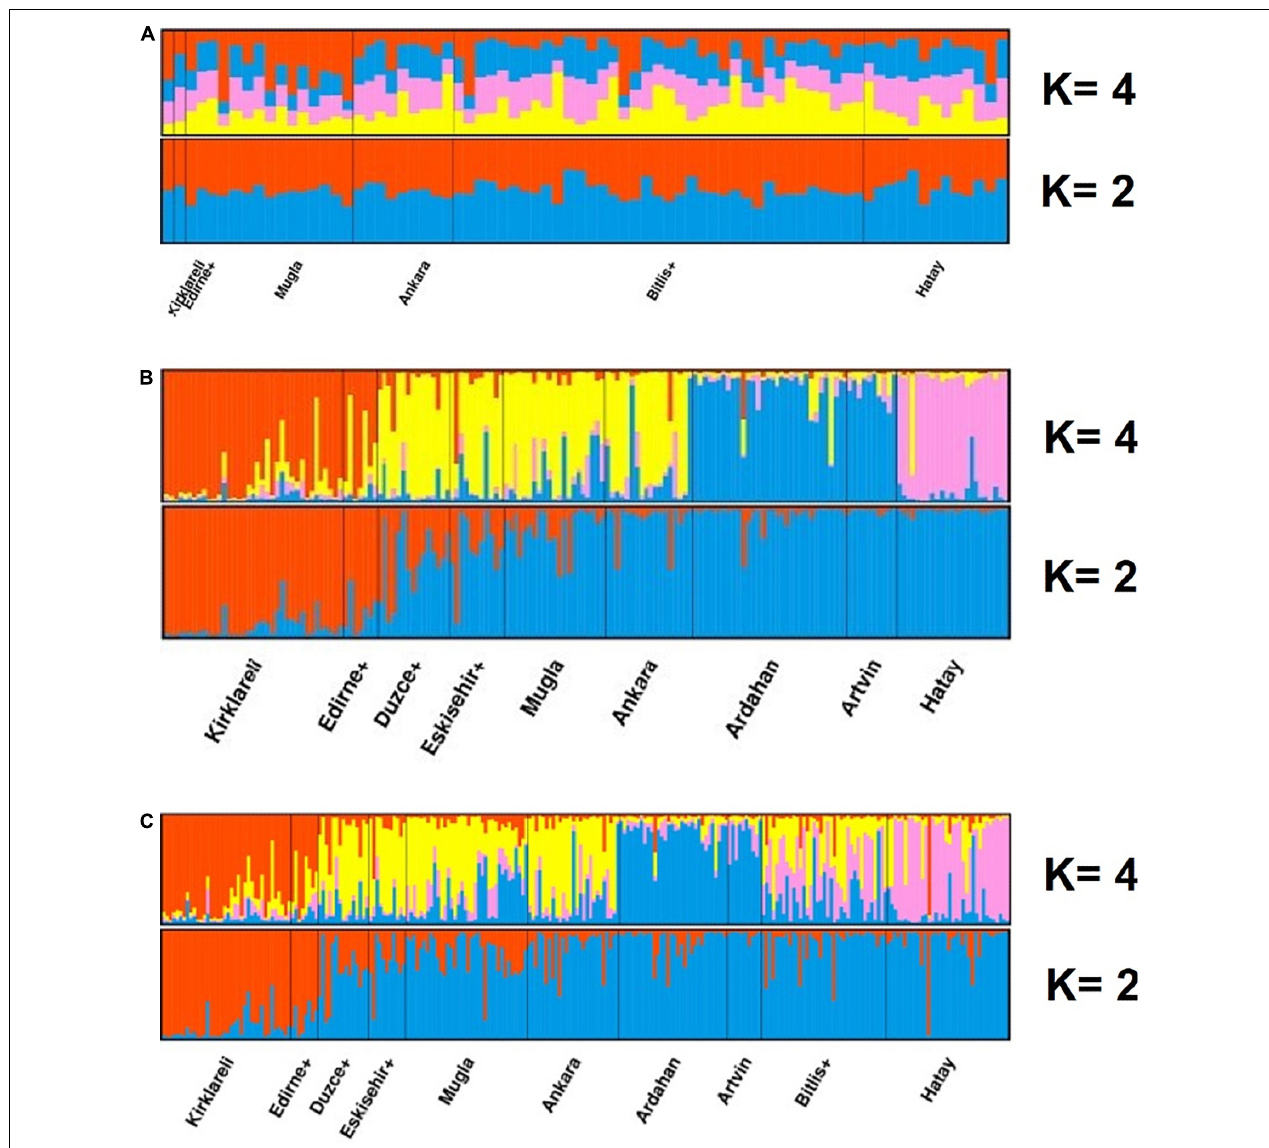
FIGURE 3 | Estimated population structure and clustering of honeybees in Anatolia and Thrace for (A) migratory colonies, (B) stationary colonies, and (C) the whole sample. Structure analysis is based on microsatellite data and suppose either K = 2 (orange: C-lineage, blue: O-lineage) or K = 4 (orange: Thracian, yellow: Anatolian, blue: Caucasian, violet: Levantine) hypothetical populations. Each individual is represented by a vertical bar and colored according to membership coefficients belonging to each cluster. K = 2 is found to be slightly likelier than K = 4. For stationary colonies at K = 2, the transition from C-lineage to O-lineage is gradual. No population structure is observed in migratory colonies in contrast to stationary ones and the overall data where four different subspecies are evident. Note the higher admixture levels in the overall data in comparison to stationary